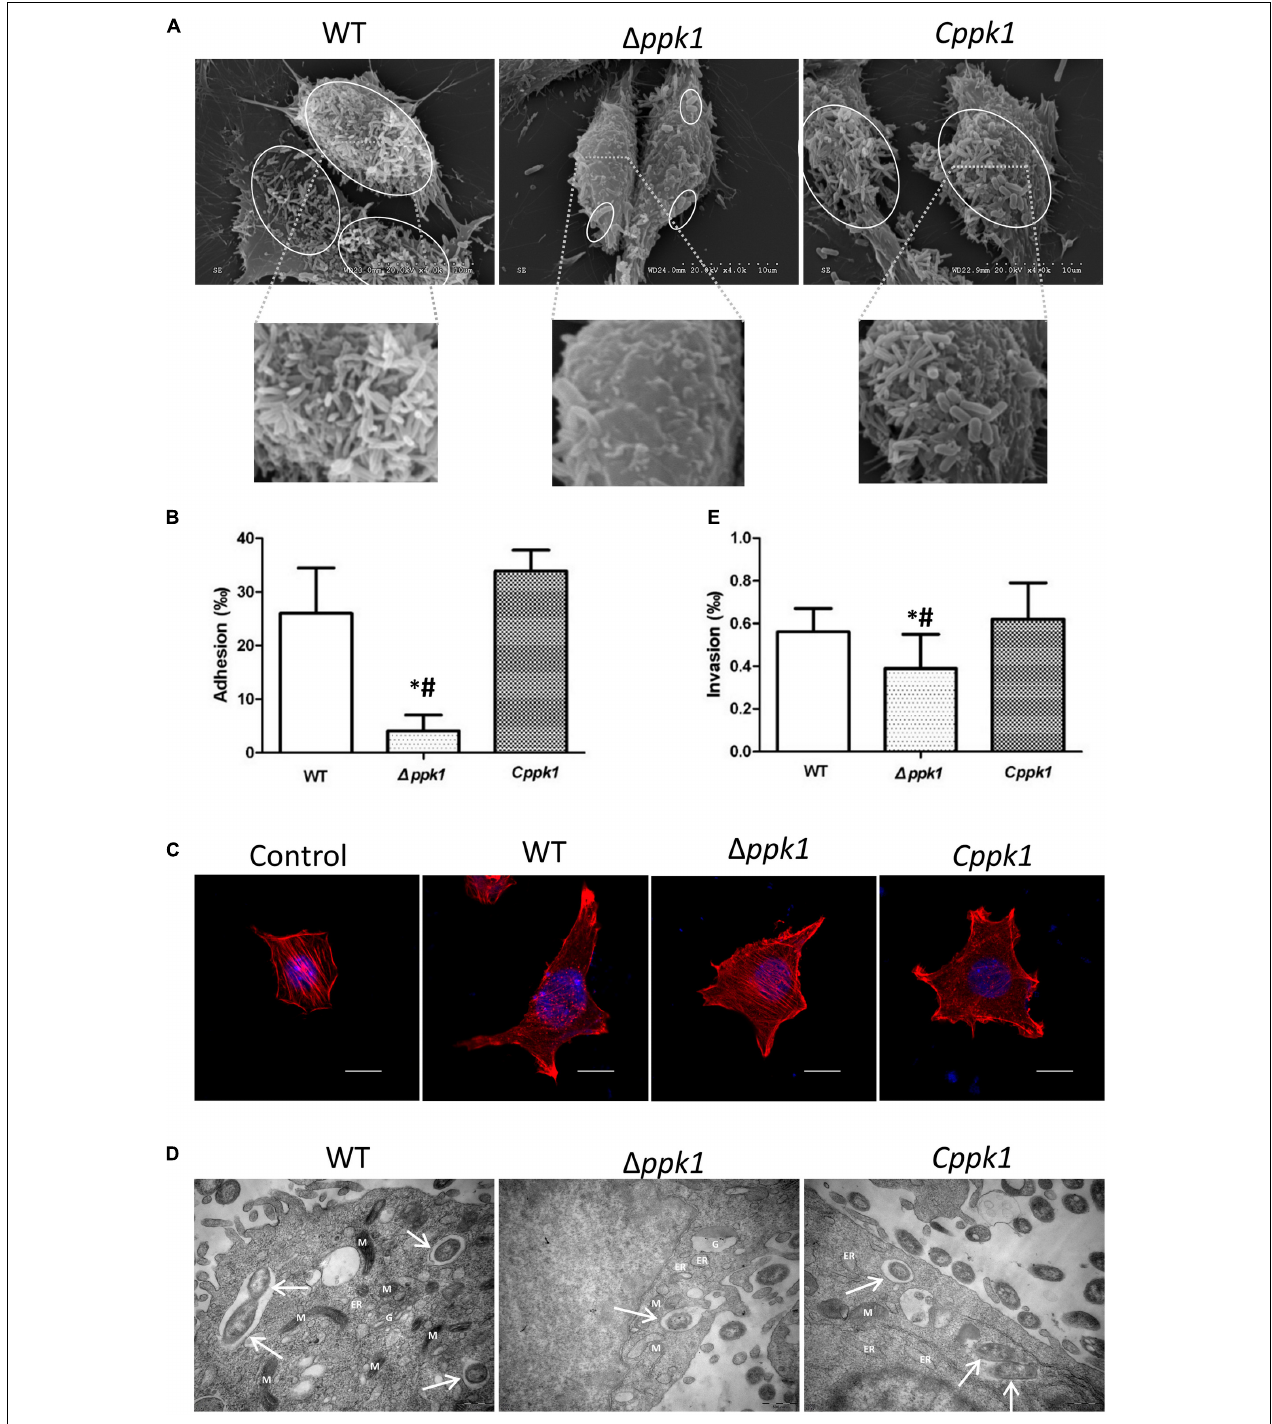
FIGURE 3 | Deletion of the ppk1 gene reduced the adhesion, A/E lesions, and invasive ability. (A) High-resolution SEM images of LoVo cells infected with WT, (cid:49) ppk1, or Cppk1 strains. Scale bar: 10 µ m. (B) Comparison of adhesion rates between the WT, (cid:49) ppk 1, or Cppk 1 strains. (C) LoVo cells were stained with rhodamine phalloidin (actin) and DAPI (nuclei) after infection. Scale bar: 10 µ m. (D) High-resolution TEM images of LoVo cells infected with WT, (cid:49) ppk1, or Cppk1 strains. White arrows point to the bacteria. ER, endoplasmic reticulum; M, mitochondria; G, Golgi apparatus. Scale bar: 500 nm. (E) Comparison of invasion rates between the WT, (cid:49) ppk 1, and Cppk 1 strains. Error bars in both (B) and (E) indicate standard deviations. *, p < 0.05 as compared with the WT strain; #, p < 0.05 as compared with the Cppk 1 strain.